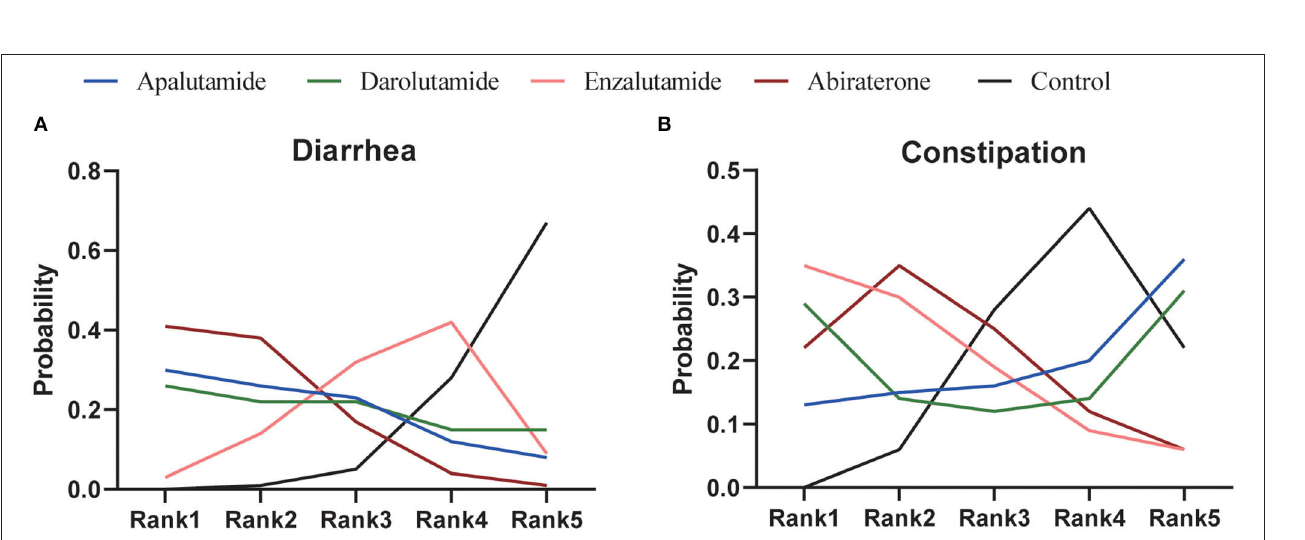
and increased inflammatory levels from GI dysbiosis